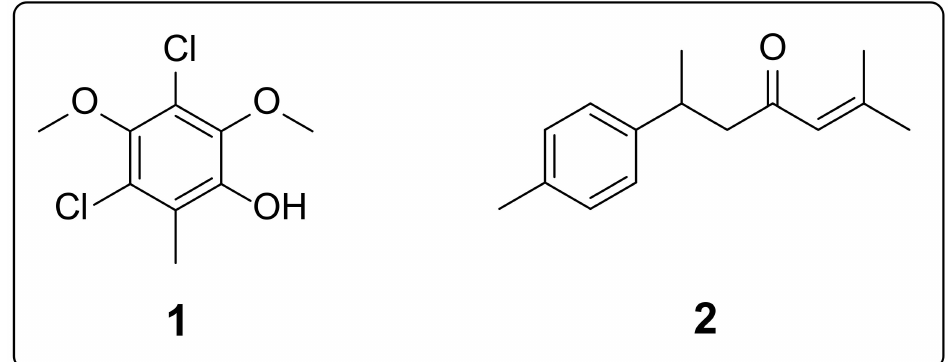
Figure 1. Isolated bioactive compounds from Fragaria indica